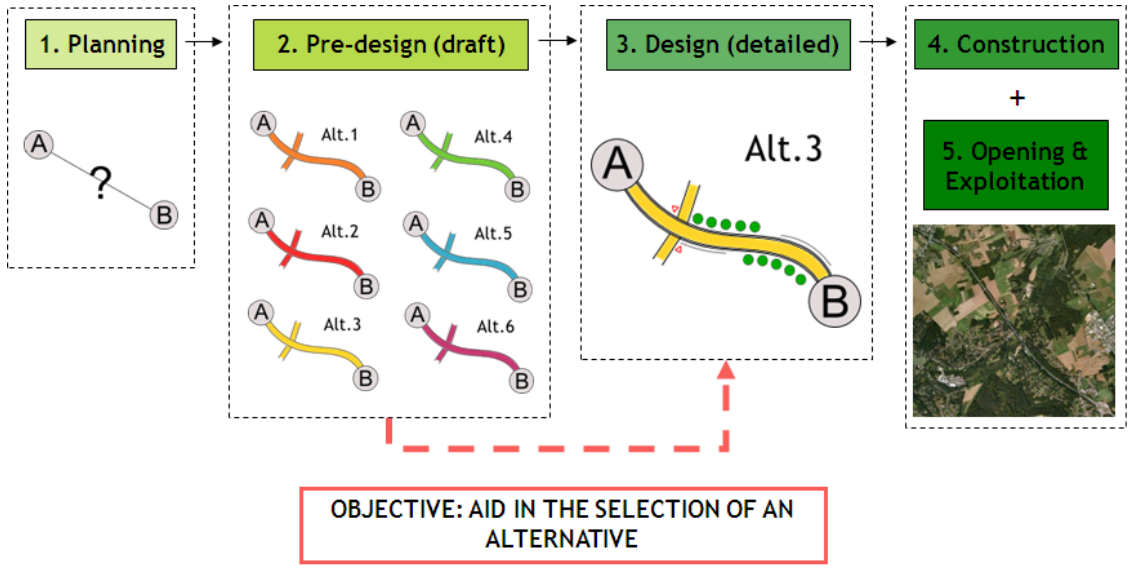
Figure 2. Design stage of an infrastructure and objective of the project